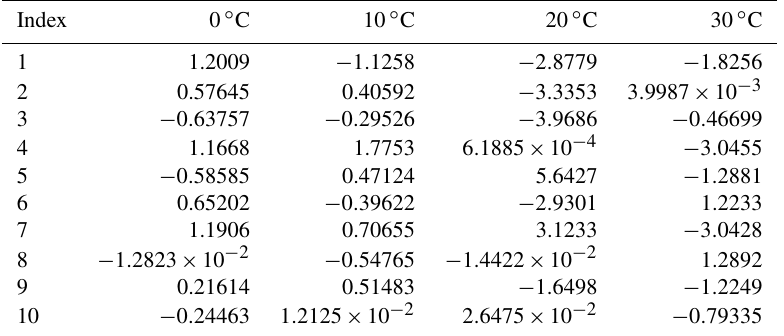
Table A1. Coefficients a 1 − 10 for the ratio K DP /Z 0 in Eq. (1). The coefficients were calculated for a 30 ◦ elevation.